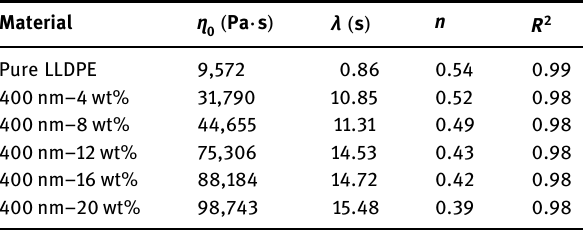
Table 2: Fitting results for the Al 2 O 3 /LLDPE composites with di ff erent fi lling contents via the Carreau model Material